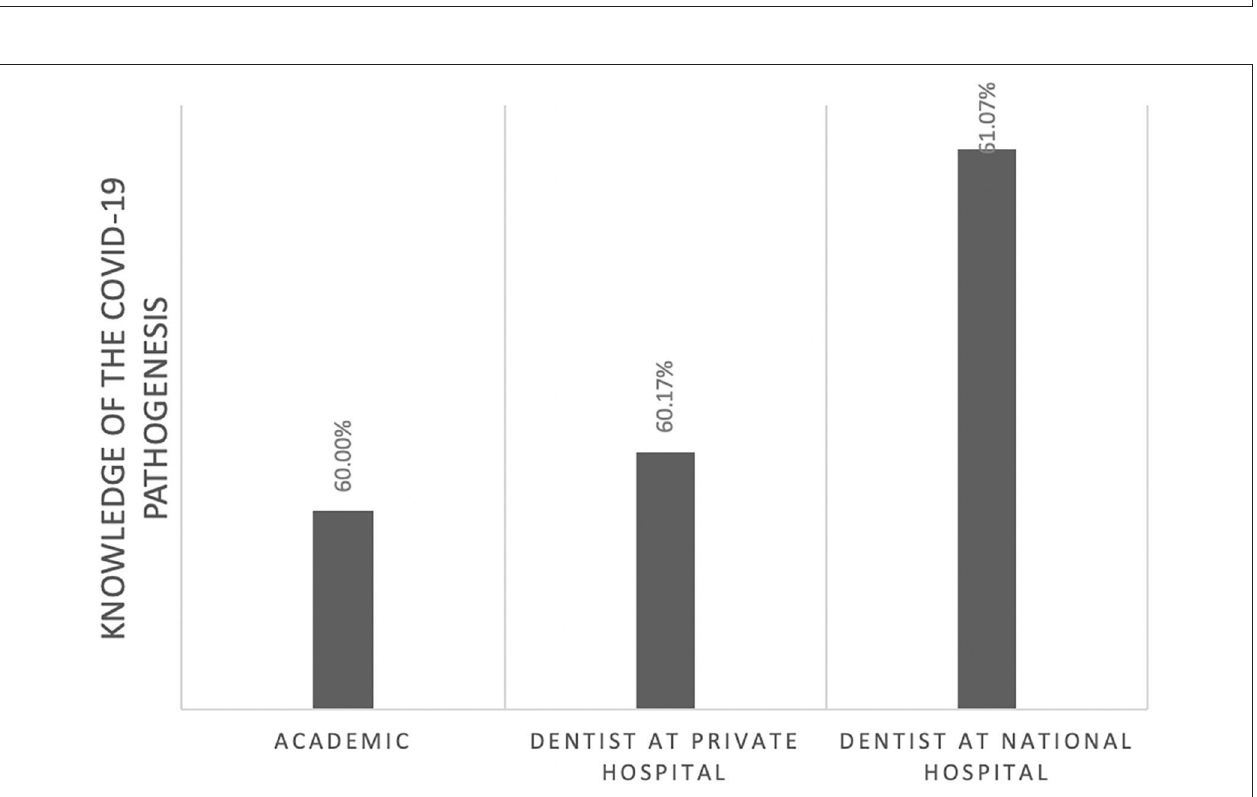
Frontiers in Medicine |